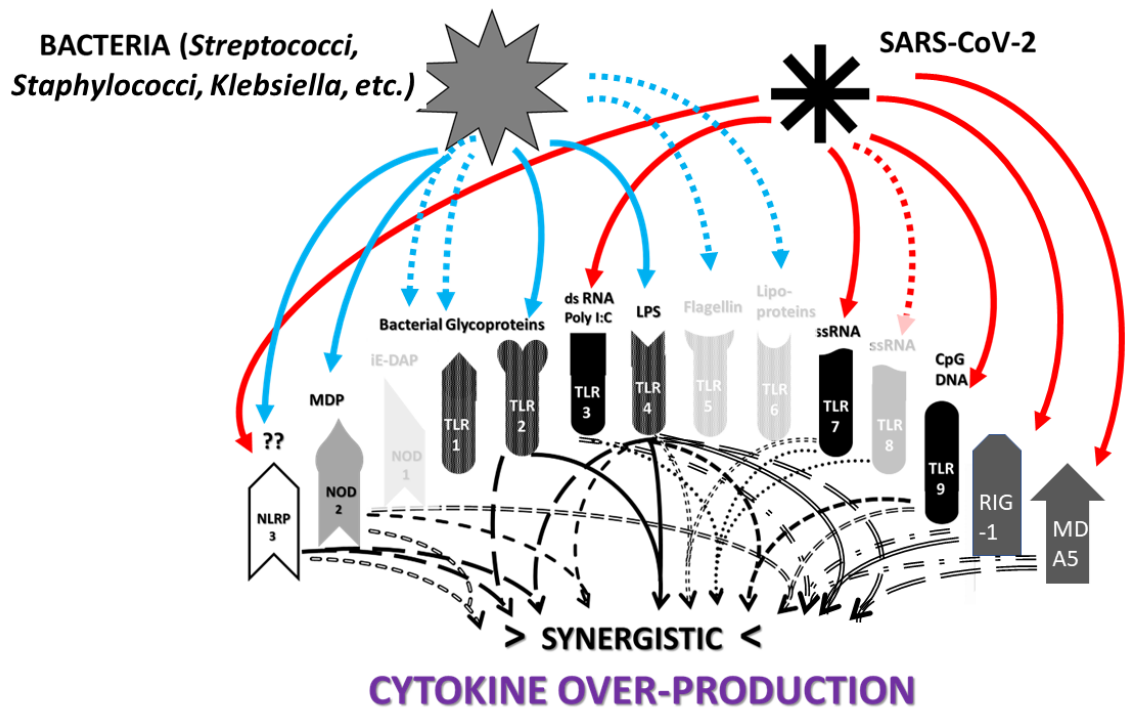
Figure 11. Summary of innate receptor activations produced by SARS ‑ CoV ‑ 2 (red lines) and bacteria (blue lines) and their synergisms. Solid red and blue lines indicate activation of receptors that has been well ‑ validated by experimental or clinical studies and that, in the case of bacteria, are common to all bacterial co ‑ and super ‑ infections commonly observed in severe COVID ‑ 19. Dotted red lines indicate possible activation by SARS ‑ CoV ‑ 2 antigens that are not well ‑ established. Dotted blue lines indicate receptor activation by only some species of bacteria that co ‑ or super ‑ infect SARS ‑ CoV ‑ 2 in severe COVID ‑ 19. The black lines indicate pairs of receptors involving well ‑ established activation patterns that produce synergisms. Receptors that may be activated (dotted red and blue lines) are not included in these synergisms, but may produce additional synergisms that add to the cytokine over ‑ production. Note that TLR4 (bacteria ‑ activated through LPS) is particularly prolific in its range of synergisms with SARS ‑ CoV ‑ 2 ‑ activated receptors.